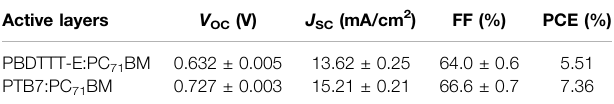
TABLE 1 | The average photovoltaic parameters of PBDTTT-E:PC 71 BM and PTB7:PC 71 BM solar cells with the corresponding deviations.